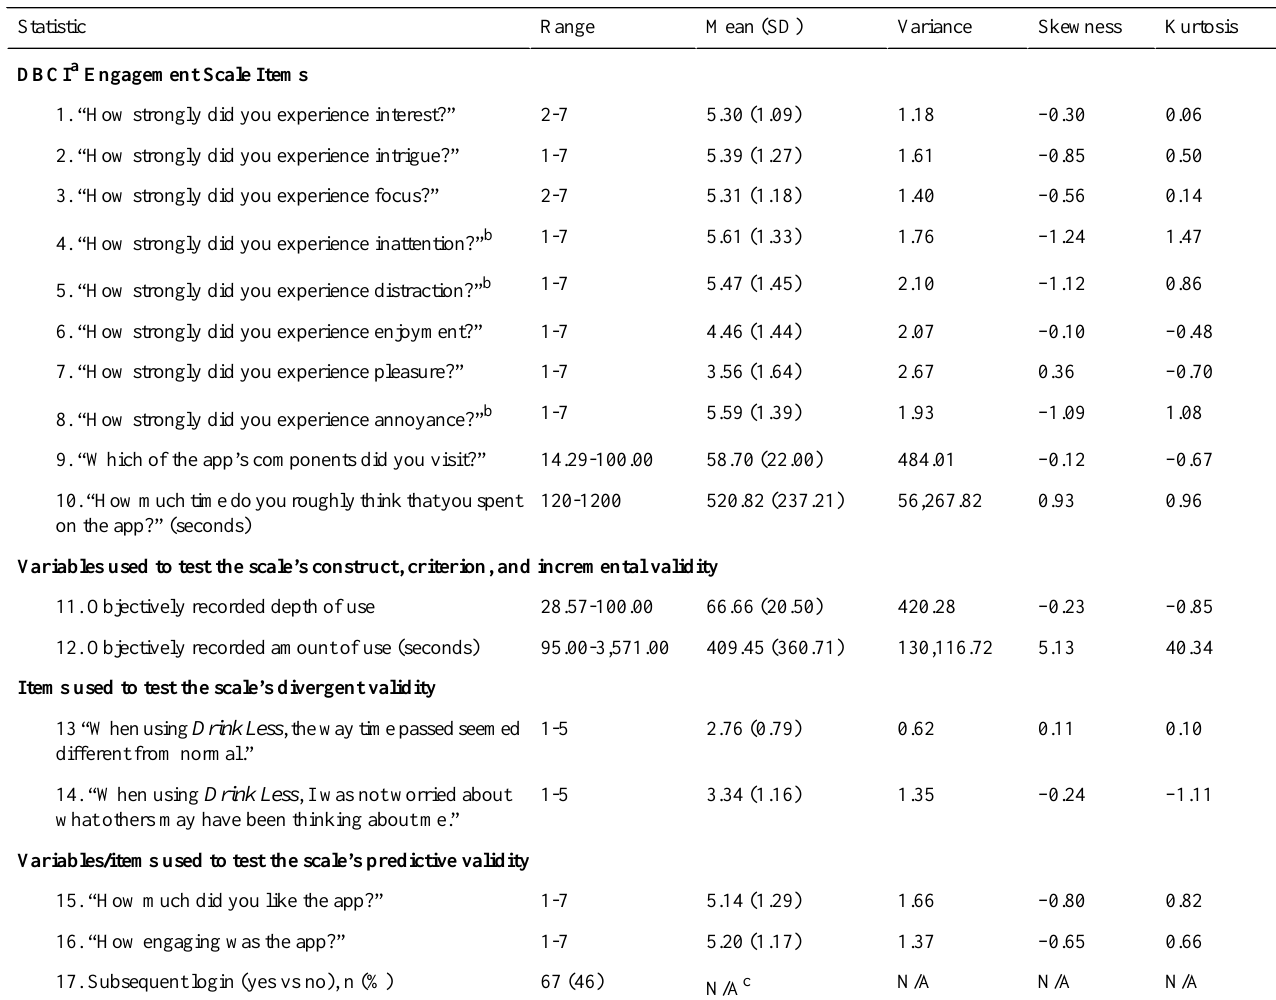
Table 2. Descriptive statistics for the scale items